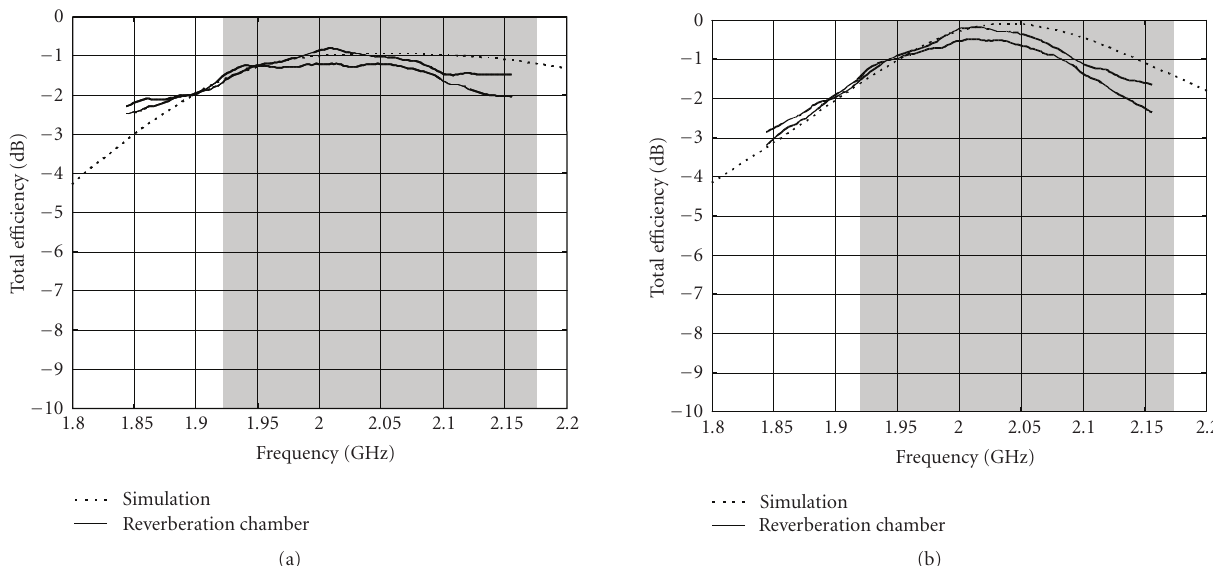
Figure 6: Simulated (IE3D) and measured (reverberation chamber) total e ffi ciency of the antenna systems; (a) initial structure, (b) neutral- ized structure.